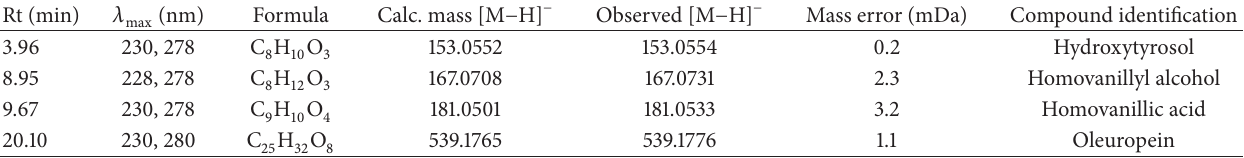
Table 1: Identification of metabolites from plasma, urine, and bile after administration of 3,4-DHPEA-EDA, hydroxytyrosol, and oleuropein. Rt (min) 𝜆 max